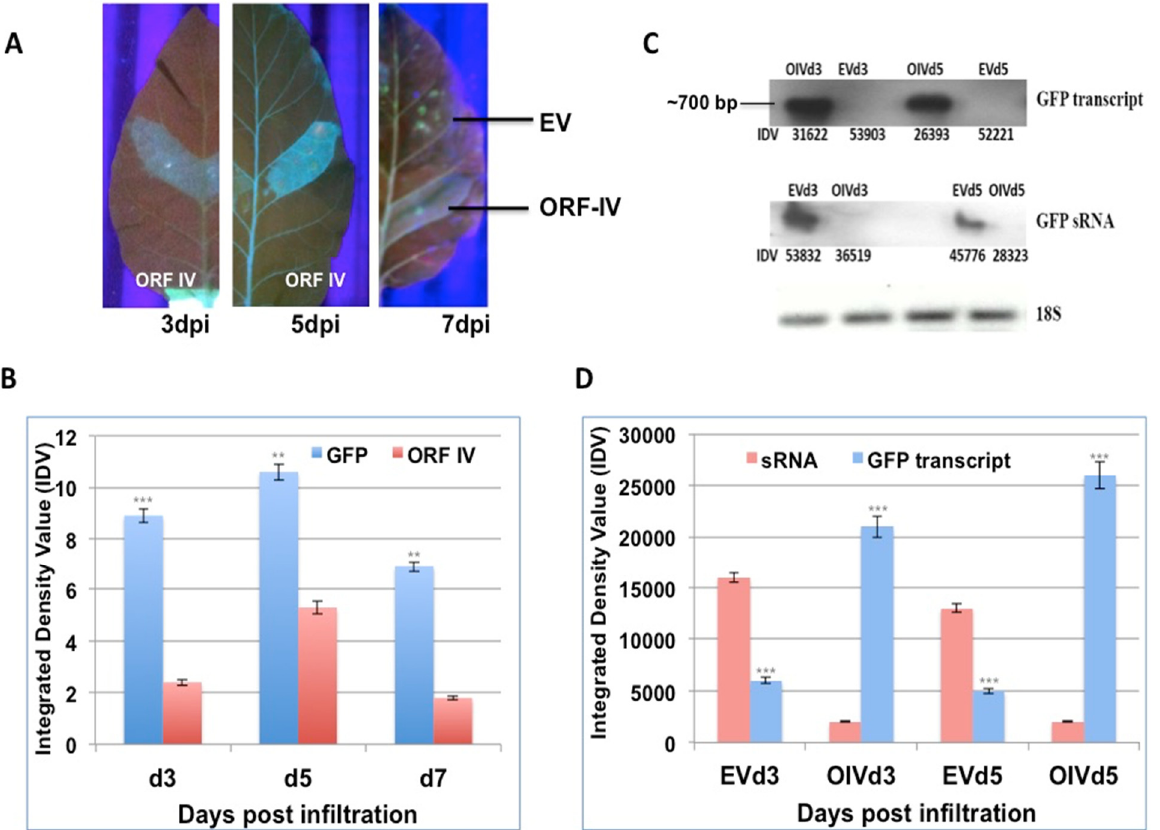
Figure 2. Reversal of GFP silencing by RTBV ORF-IV and its molecular analysis. ( A ) The different panels exhibit GFP fluorescence in the region infiltrated with ORF-IV at 3, 5, and 7 days post infiltration (dpi). The region infiltrated with the empty vector (EV) served as the control. ( B ) The graph represents the normalized Integrated Density Values (IDV) for the GFP and ORF-IV transcripts relative to 18S control cDNA at 3 dpi (d3), 5 dpi (d5), and 7 dpi (d7). ( C ) Northern blots of GFP transcript and GFP sRNA in regions infiltrated with ORF-IV (OIV) and EV. The 18S cDNA band served as the control. ( D ) The graph represents the normalized values of GFP transcripts and GFP siRNA as measured in the infiltrated regions at 3 dpi and 5 dpi. **, *** Significance at probability levels of 1% and 0.1%, respectively (ANOVA single